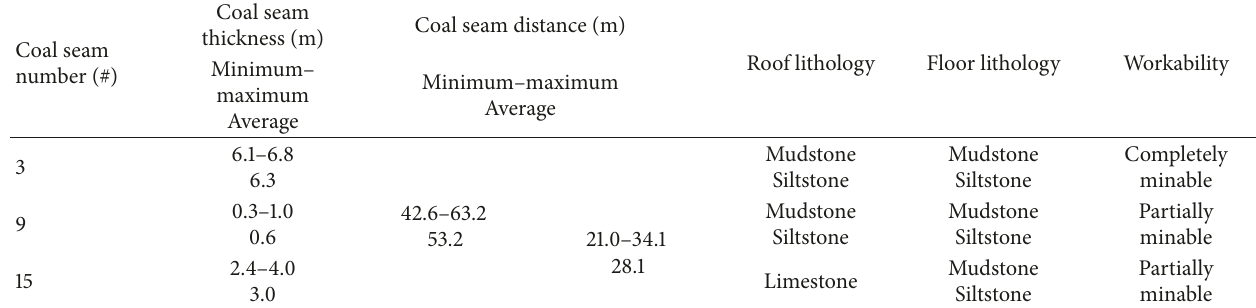
Table 1: Coal seam occurrence in the Yongan